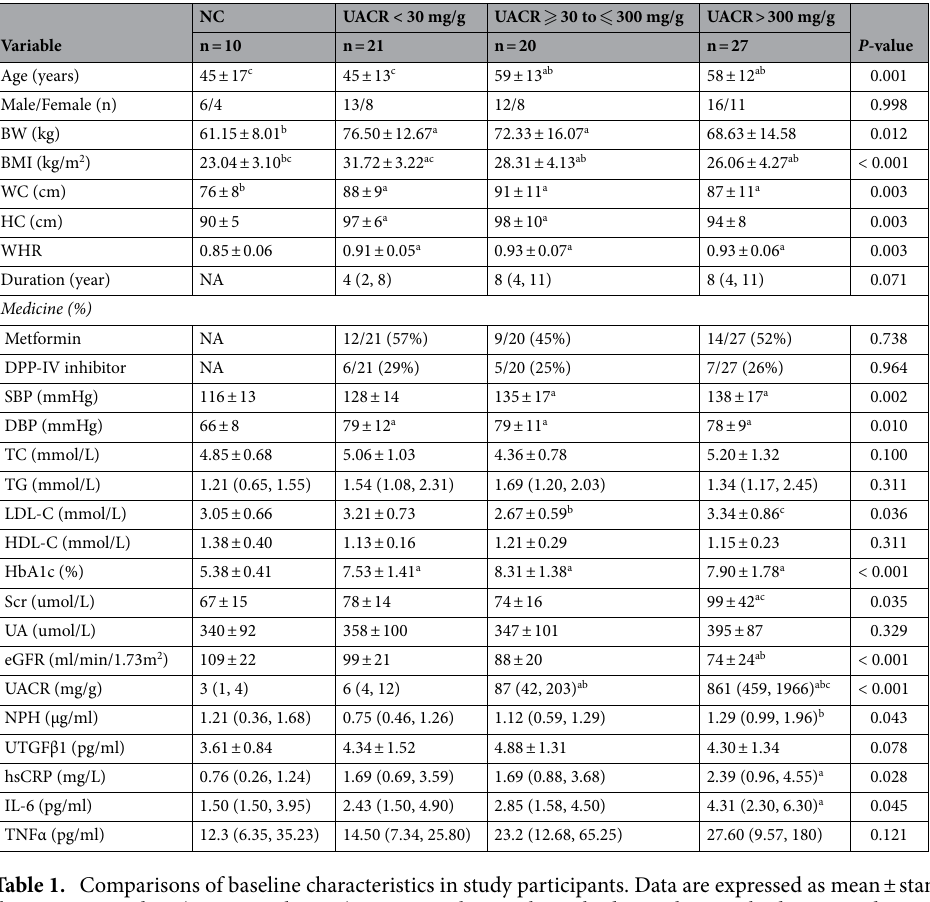
Table 1. Comparisons of baseline characteristics in study participants. Data are expressed as mean ± standard deviation or median (interquartile rang). NC normal control, BW body weight, BMI body mass index, WC Waist Circumference, HC Hip Circumference, WHR Waist hip ratio, SBP Systolic blood pressure, DBP Diatolic blood pressure, TC Total choles-terol, TG triglycerides, LDL-C low-density lipoprotein cholesterol, HDL- C high-density lipoprotein cholesterol, HbA1c glycated haemoglobin, Scr serum creatinine, UA Uric acid, eGFR estimated Glomerular Filtration Rate, UACR urine albumin/creatinine, UTGFβ1 urine transforming- growth-factor-beta1, NPH nephrin, hsCRP High sensitivity C-reactive protein, IL-6 Interleukin-6, TNFα Tumor necrosis factor α. a Versus NC Group, P < 0.05. b Versus UACR < 30 mg/g Group, P < 0.05. c Versus UACR ≥ 30to ≤ 300 mg/g Group, P < 0.05.